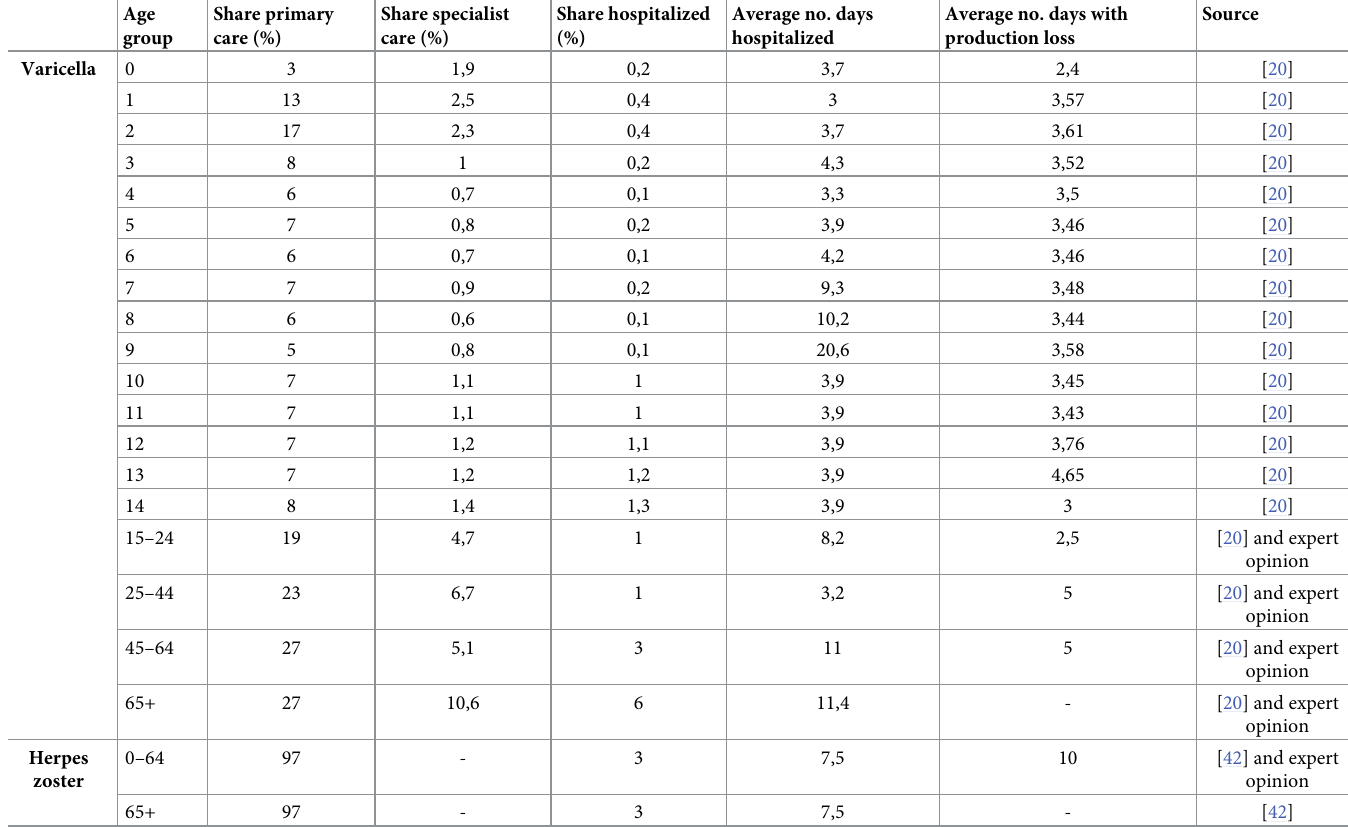
Table 1. Resource use. Resource use for or varicella and herpes zoster applied in the model, the share of cases in each health care setting, by age